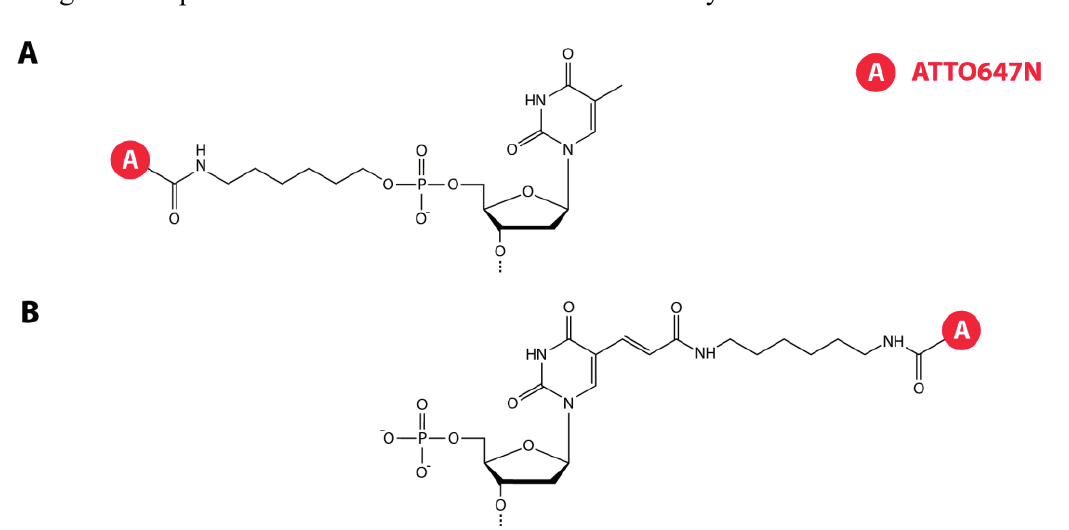
Figure 5. Chemical drawings of the acceptor labeling strategies. ( A ) In terminal labeling the acceptor is coupled to the amino-C6-modified 5'-phosphate-thymidine; ( B ) In base labeling the acceptor is attached to an amino-C6-modified